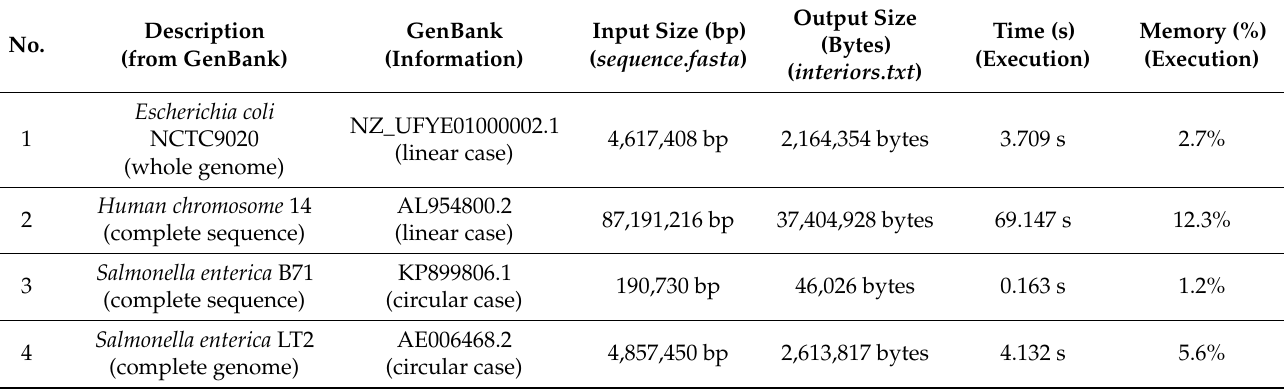
Table 2. Experimental results obtained on the computational server (Min = 200, Max =